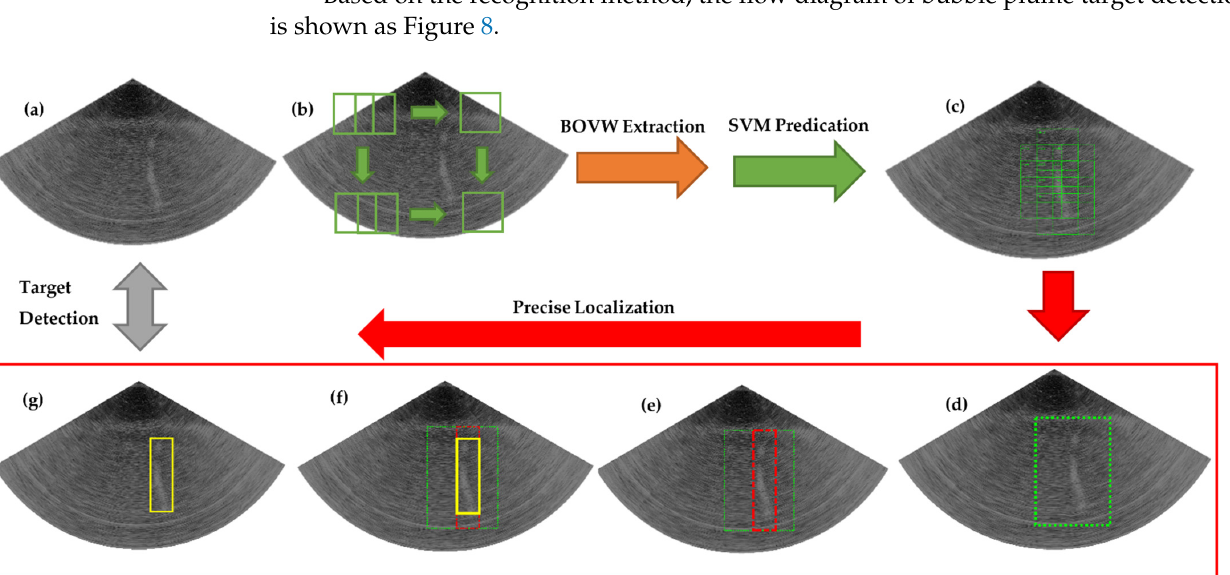
Table 2. Accuracy assessment of SVM binary classification.